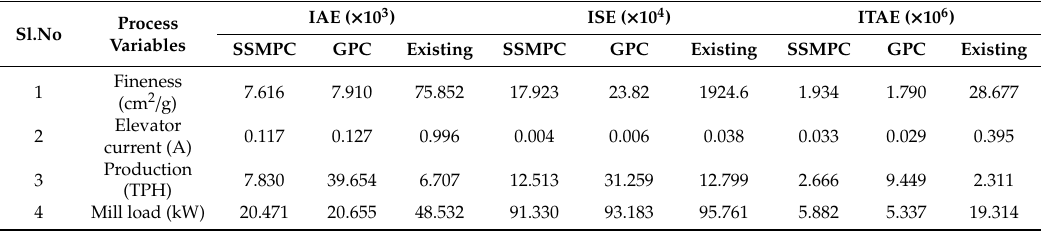
Table 3. Error performance indices for the di ff erent controllers implemented in the real-time simulator under the closed-loop